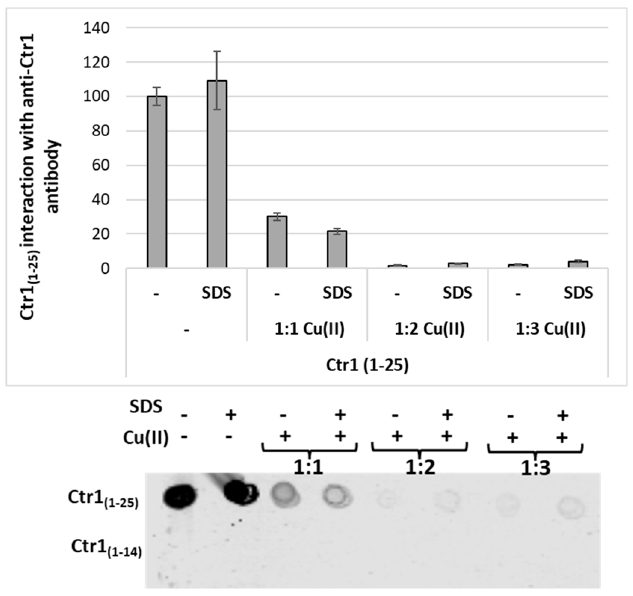
Figure 7. Immunoblots of Ctr1 (1-14) and Ctr1 (1-25) peptides (1 mM) pre-incubated with different concentrations of copper (L/Cu 2+ ratios 1:1, 1:2, 1:3) with or without 1% SDS. The membrane was incubated with anti-Ctr1 extracellular domain antibody.